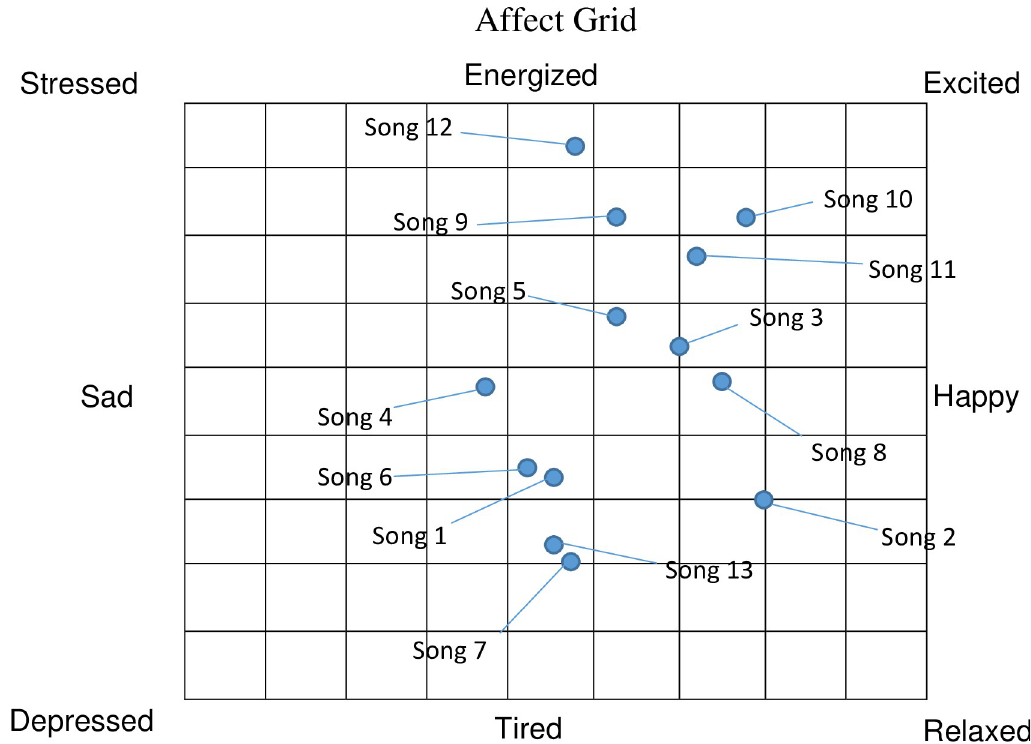
Fig 1. The affect grid for the ratings of the 13 selected musical background. Raters were instructed to rate how they are feeling right now and place one checkmark in the grid. The score is calculated according to the number of the squares. The horizontal dimension is used to score the pleasure-displeasure score, counting 1 to 9 starting at the left. The vertical dimension is used to score the arousal-sleepiness score, counting 1 to 9 starting at the bottom.